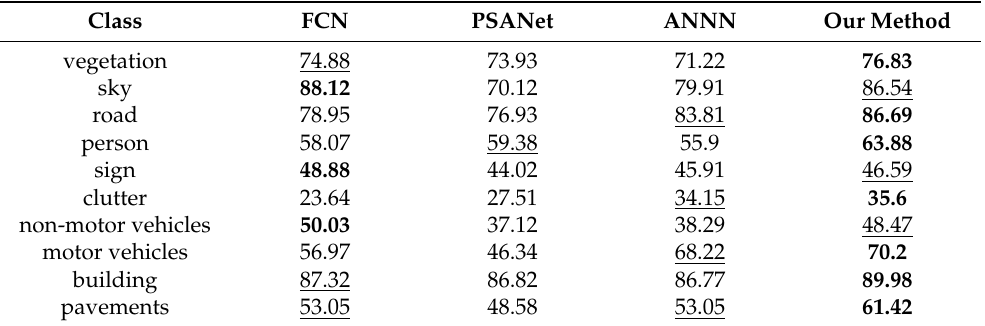
Table 4. IoUs for each category among the candidate CNNs. Best results in each class are in bold ; second best are underlined.